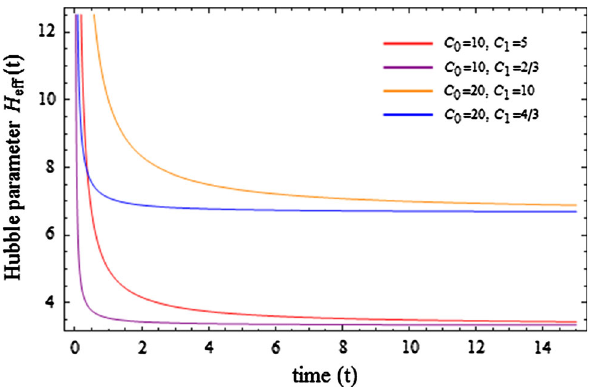
Fig. 1 The behavior of the obtained effective Hubble parameter H eff with various values of C 0 , C 1 of C 1 . However, in all cases, the deceleration parameters are negative and become constants ( ∼ − 1) at late time.